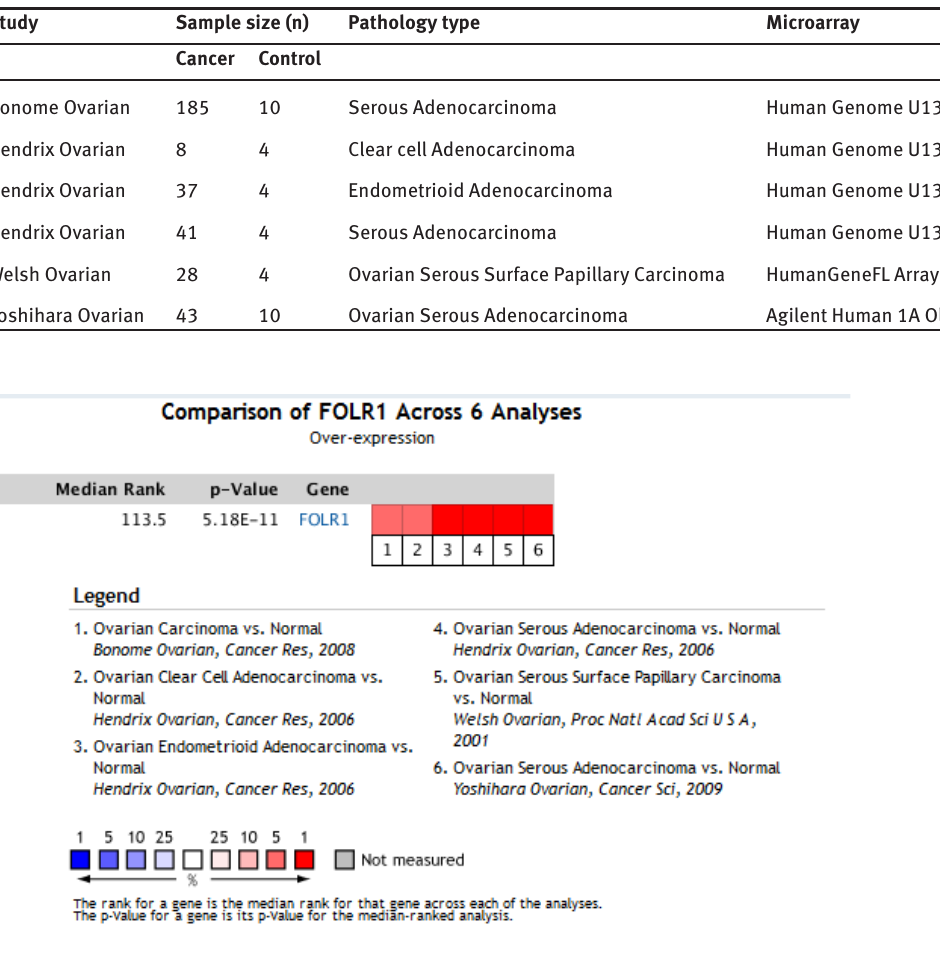
Figure 2: Expression of FOLR1 in ovarian cancer in the studies identified by the Oncomine database. 1-6 represent the six datasets expressing FOLR1 in ovarian tumors. The darker the red, the higher the FOLR1 gene expression from the